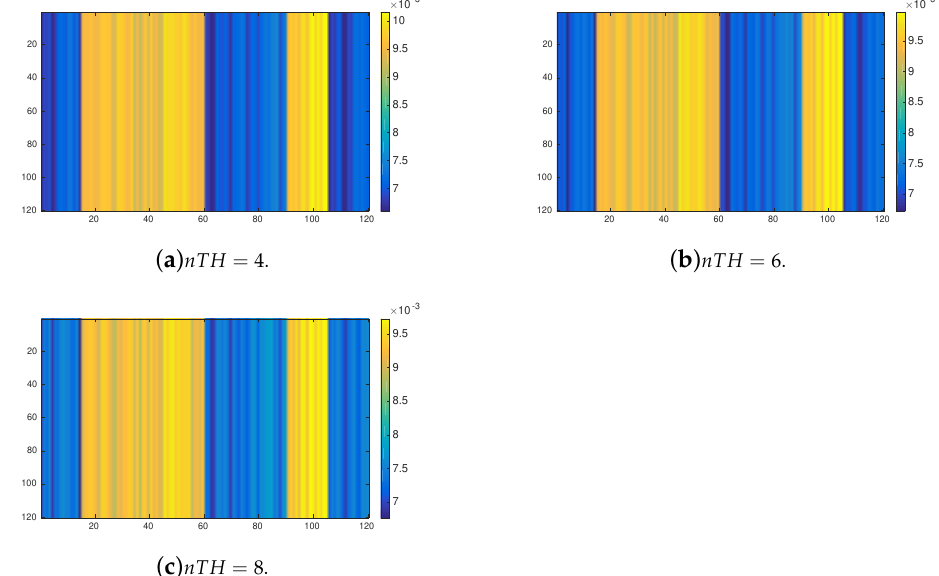
Figure 10. Probabilistic transition matrix, induced by the OPRF, powered after 500 iterations ( P 500 ) for the 120 tasks arranged into 8 clusters and different values of nTH .